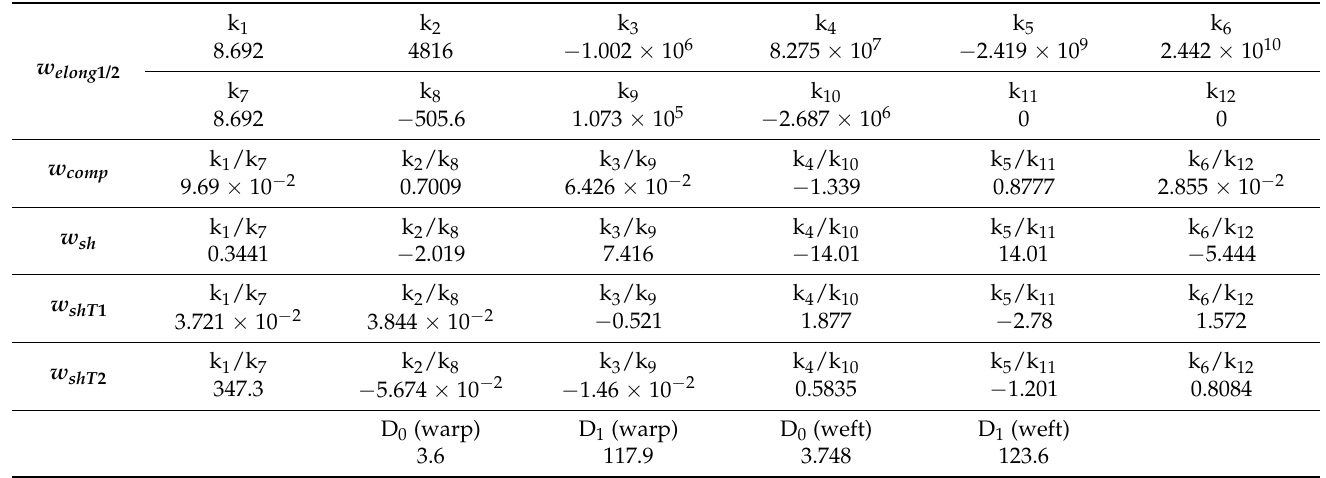
Table A1. Material parameters identified in the macroscopic simulations (k i in MPa; D 0 in Nmm; D 1 in Nmm 2